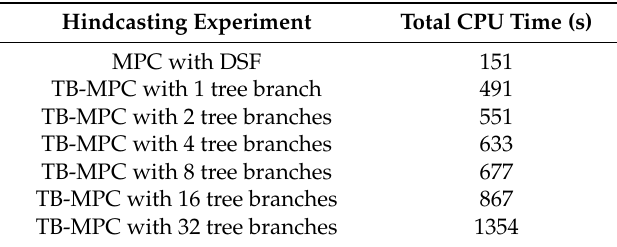
Table 2. Computation times in MPC hindcasting experiments. MPC stands for Model Predictive